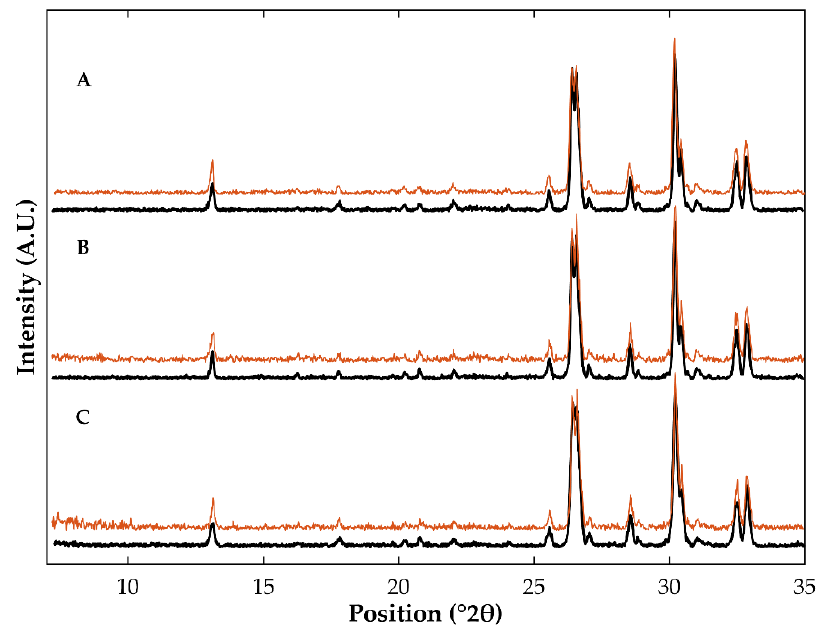
Figure 9. Diffractograms of samples obtained from pellets containing olanzapine and saccharin on the surface ( A ) or in the matrix of the beads, using the crystalline ( B ) or the co-amorphous form ( C ), as starting materials. Colors reflect the storage time: 0 (black) or 9 months (orange).